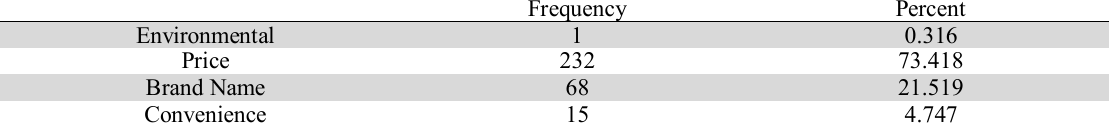
Relative Importance of Various Factors in Purchase